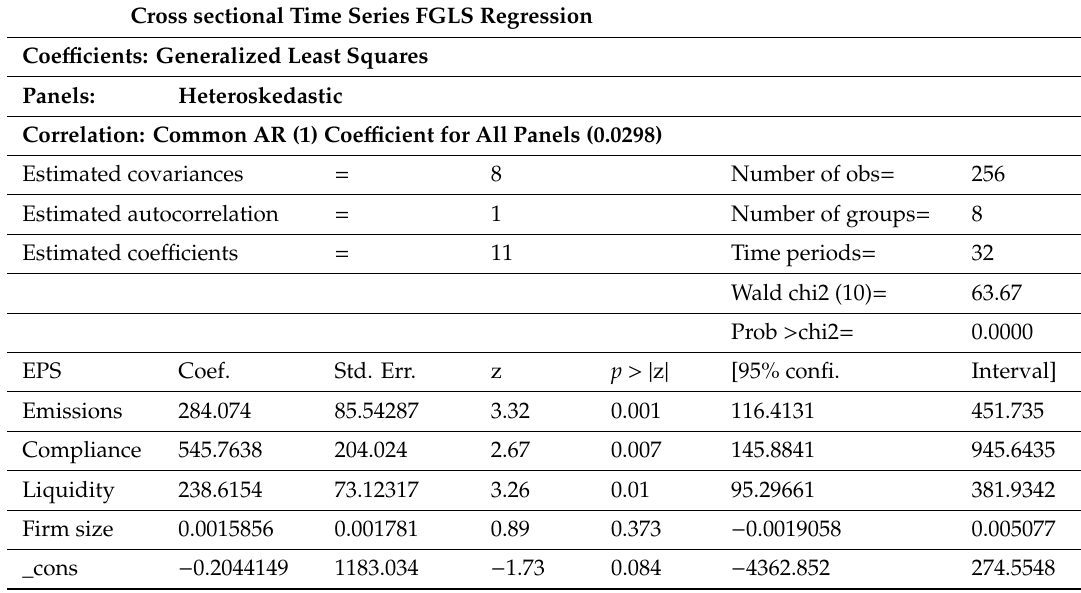
Table 5. Model 1 Feasible Generalized Least Squares (FGLS)